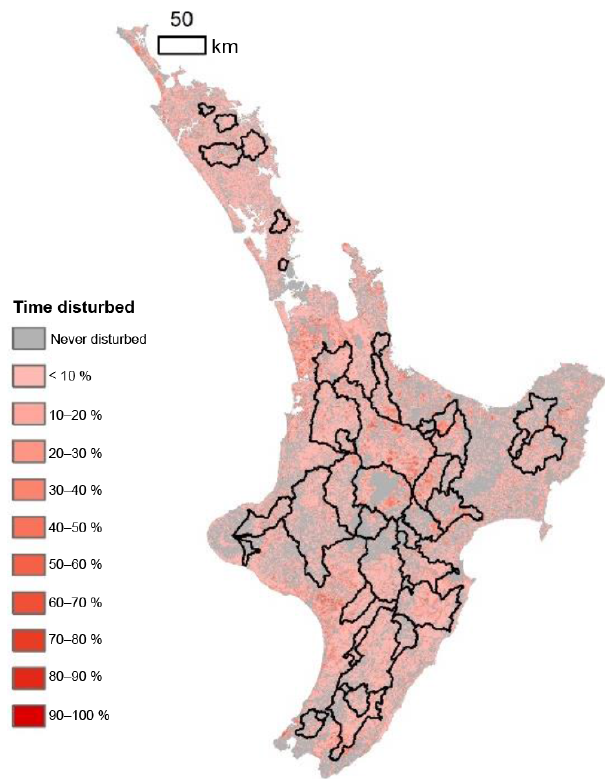
Figure 3. Disturbance frequency of North Island per 463m pixel, based on interpretation of MODIS data 2000–2013.